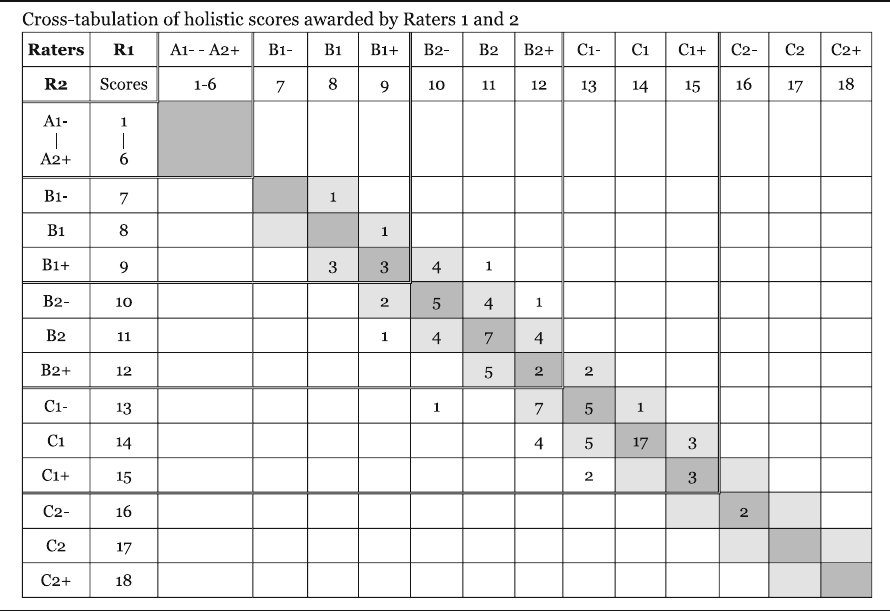
Table 7 Cross-tabulation of holistic scores awarded by Raters 1 and 2